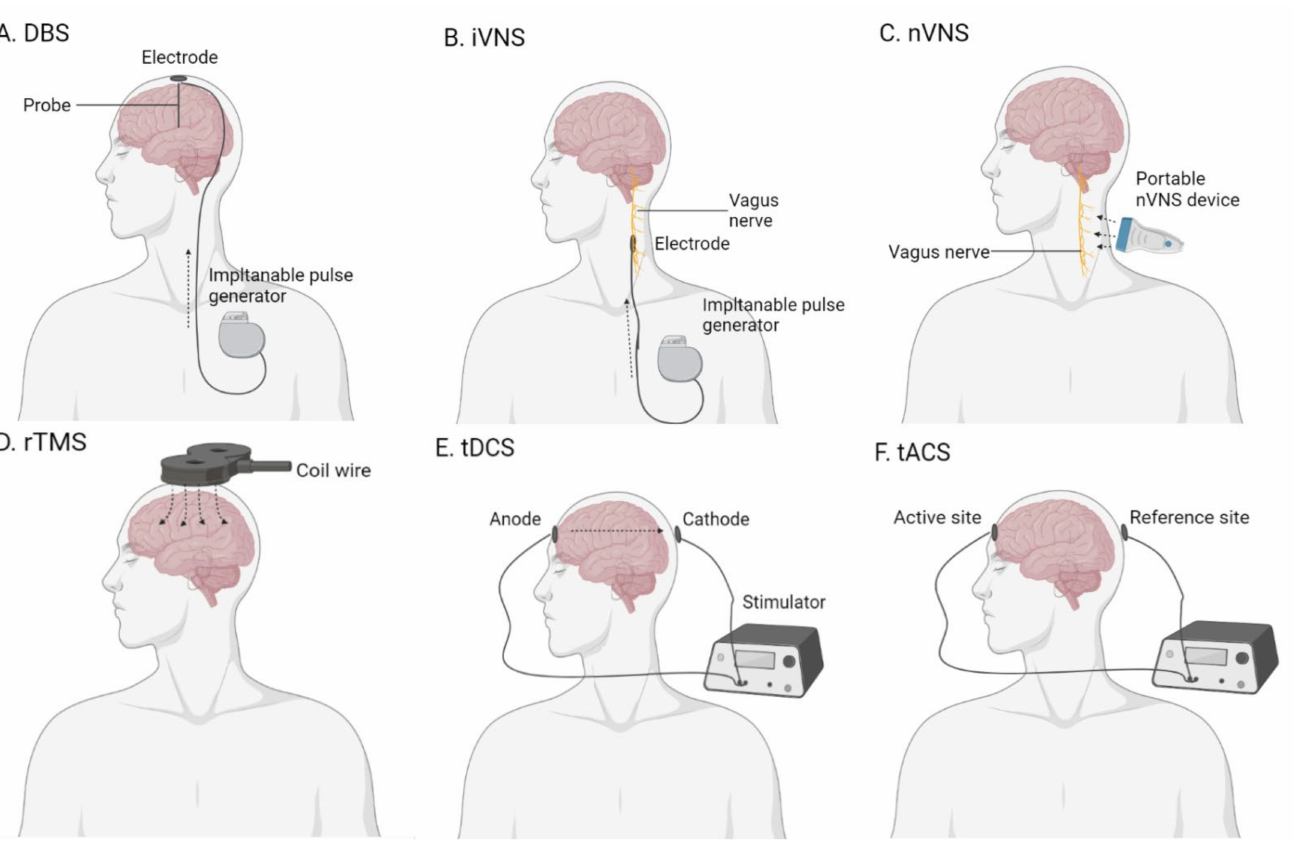
Figure 3. The diagram of the brain stimulation devices. ( A ) Deep-brain stimulation (DBS); ( B ) invasive vagus nerve stimulation (iVNS); ( C ) non-invasive vagus nerve stimulation (nVNS); ( D ) repetitive transcranial magnetic stimulation (rTMS); ( E ) transcranial direct current stimulation (tDCS); ( F ) transcranial alternating current stimulation (tACS). Created with BioRender.com. The sharp arrow means the direction of energy